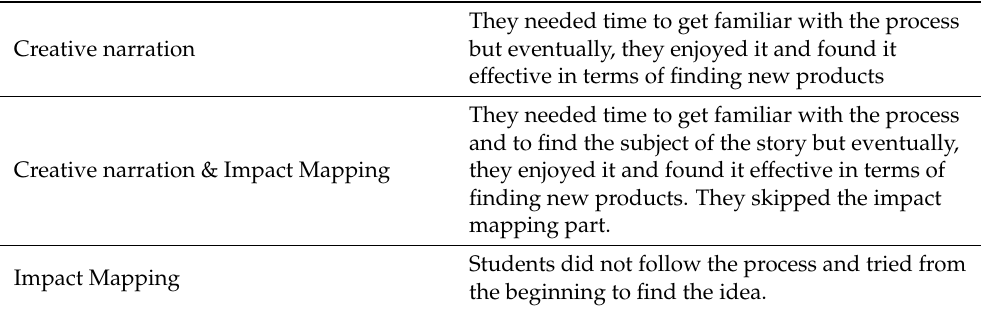
Table 1. The three techniques of the second workshop.